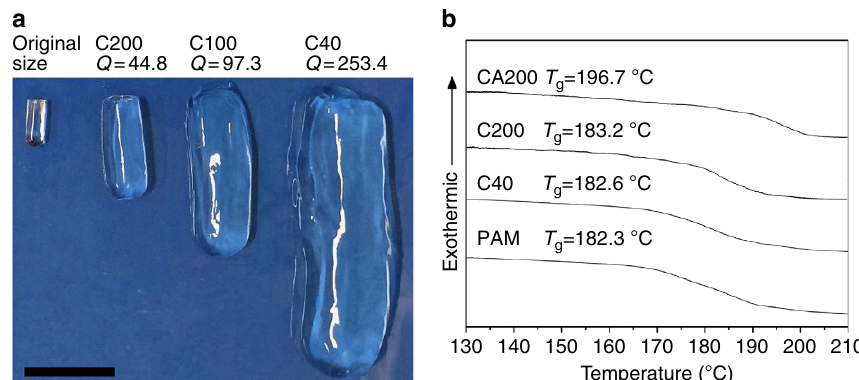
Figure 6 | Mobility and flexibility of the polymer molecules for PAM/CNS NC gels. ( a ) An optical photo of swollen hydrogels of C40, C100 and C200 after soaking at a large excess of deionized water for 3 weeks. Scale bar, 60mm. ( b ) DSC curves showing that the values of T g for C40 and C200 are slightly higher than that for the neat PAM, and the T g of CA200 is obviously higher than the others.